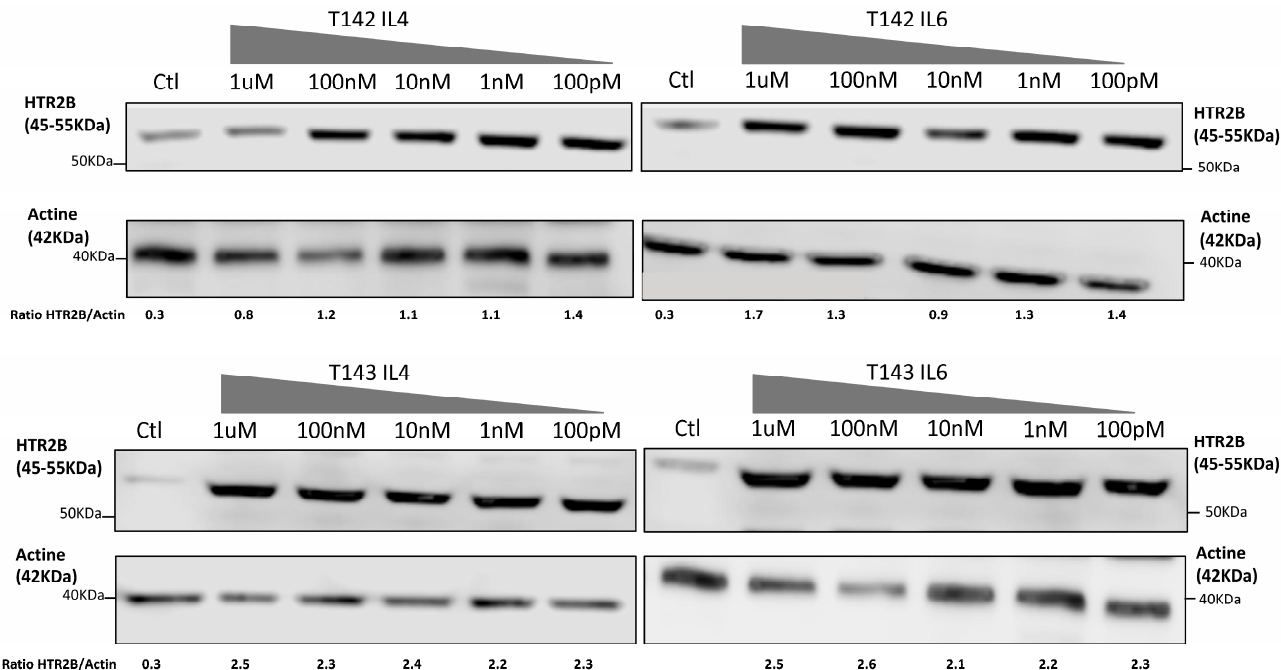
Figure 4. Expression of HTR2B in response to stimulation with IL-4 and IL-6. Expression of HTR2B was monitored by Western blot in both T142 and T143 UM cells cultured either alone (Ctl) or in the presence of increasing concentrations of IL4 and IL6 (100 pM to 1 µ M). Values shown beneath each blot correspond to the ratio of the HTR2B signal over that of actin. Both IL-4 and IL-6 con- siderably increased expression of HTR2B in T142 and T143 UM cells relative to untreated cells (negative